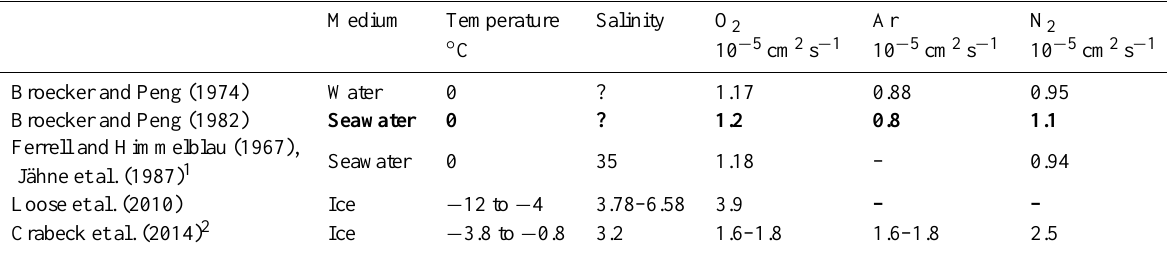
Table 1. Diffusion coefficients of O 2 , Ar and N 2 found in the literature for different medium (water, seawater and sea ice) for temperature at or below 0 ◦ C. Salinity is given when available. The diffusion coefficients in use in the present study are those of Broecker and Peng (1982) (in